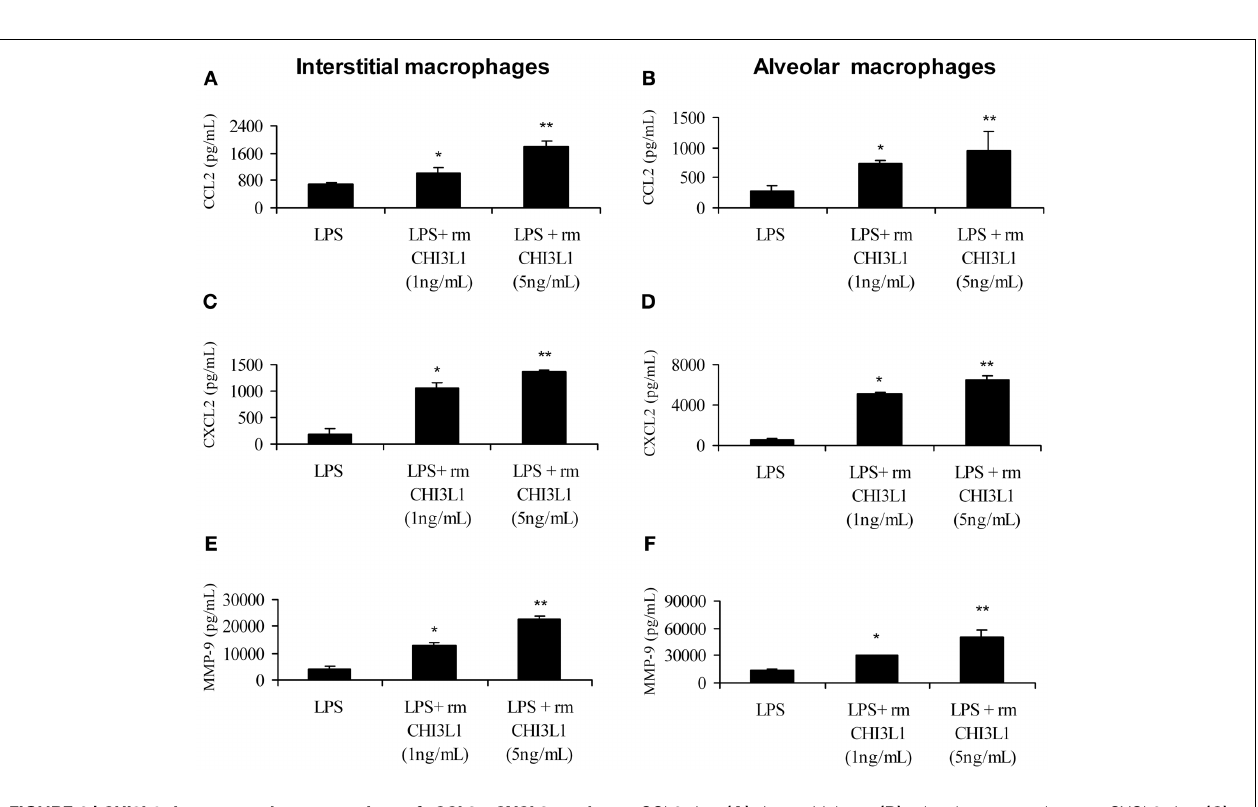
CCL2 in: (A) interstitial or (B) alveolar macrophages; CXCL2 in: (C) interstitial or (D) alveolar macrophages; and MMP-9 in: (E) interstitial or (F) alveolar macrophages. For all experiments, N = 10/group; ∗ p ≤ 0 . 05; ∗∗ p ≤ 0 .